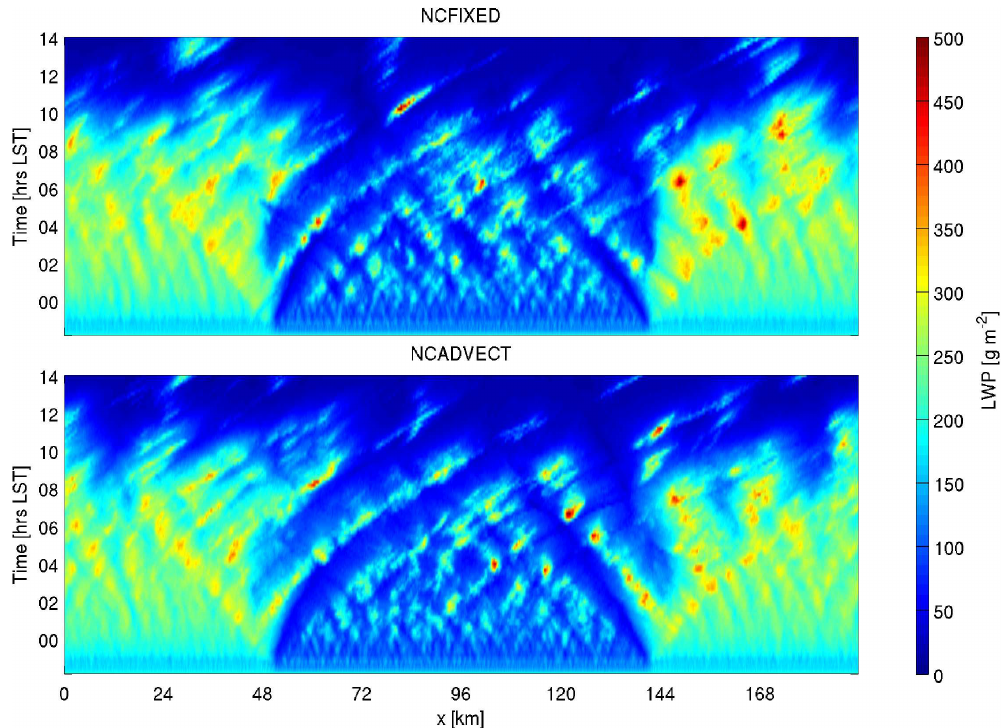
Fig. 6. Comparison of Hovm¨oller plots for y -averaged LWP from the NCFIXED and NCADVECT cases.